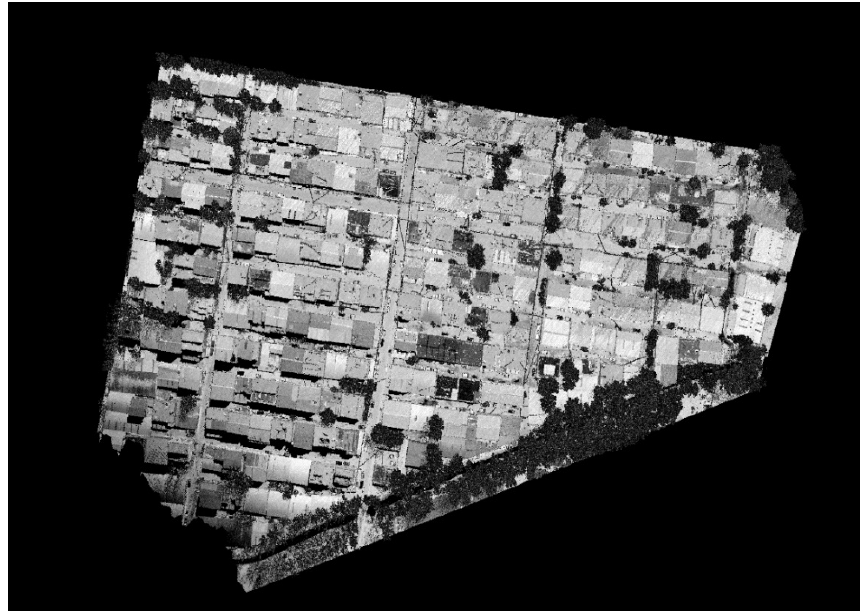
Figure 6. UAV LiDAR data. The image above is a top view of the UAV LiDAR data in Xinyang, Henan, China in terms of the intensity information.